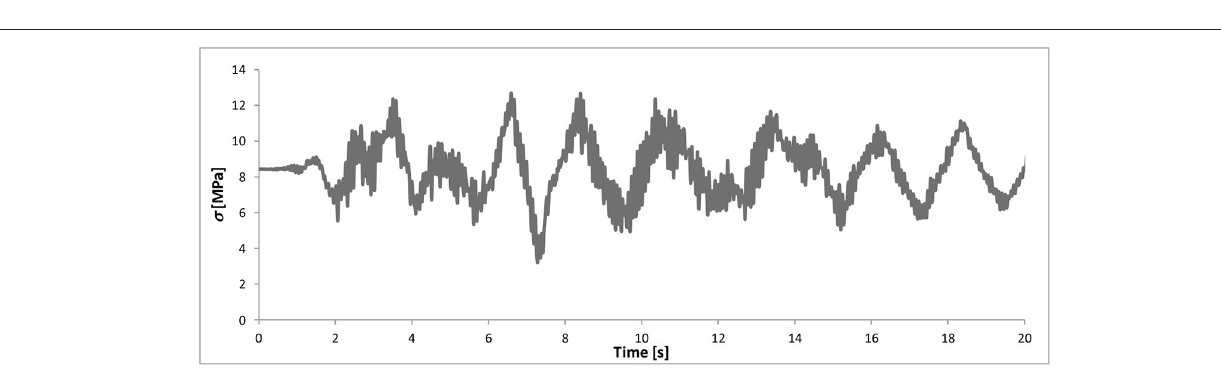
FIGURE 7 | Plan view of the isolation system of the nuclear building in Perotti et al. (2013). Position of the devices where the time histories are collected.